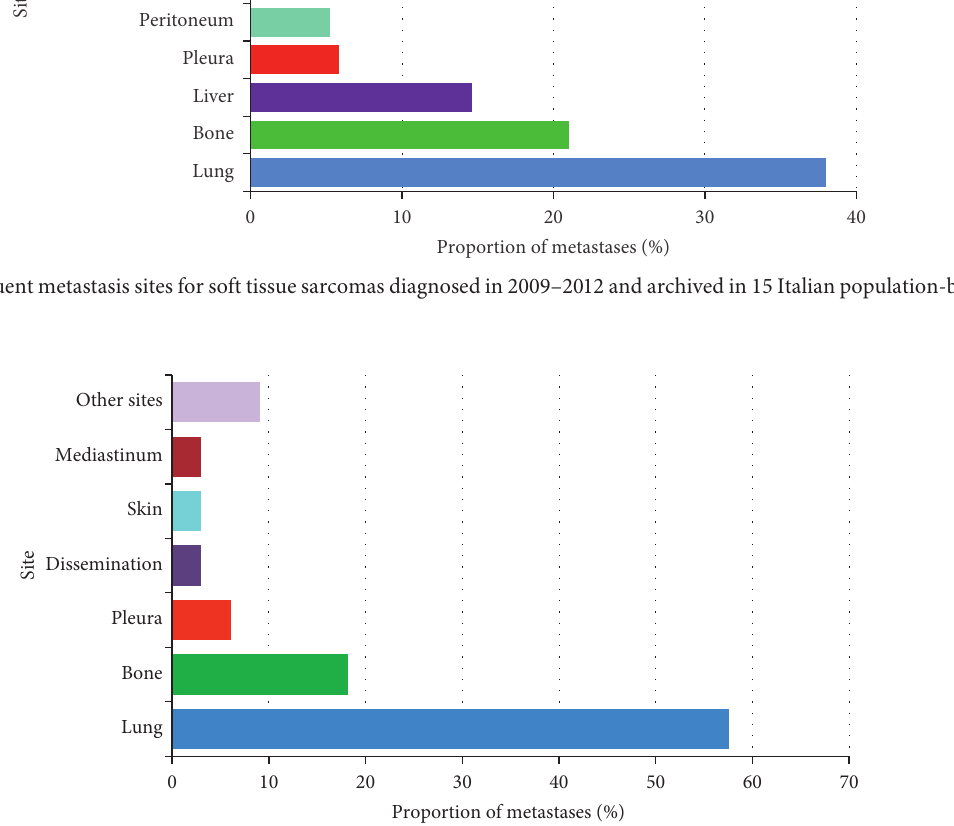
Figure 2: Most frequent metastasis sites for bone sarcomas diagnosed in 2009–2012 and archived in 15 Italian population-based cancer